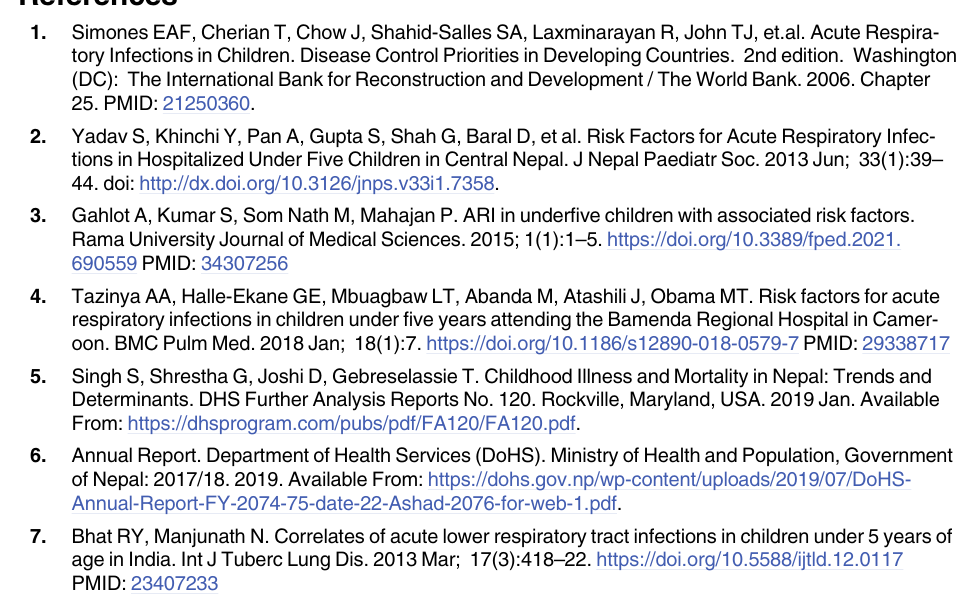
S2 Table. Distribution of child related environmental characteristics. n = 286. S3 Table. Health information of the child. n =